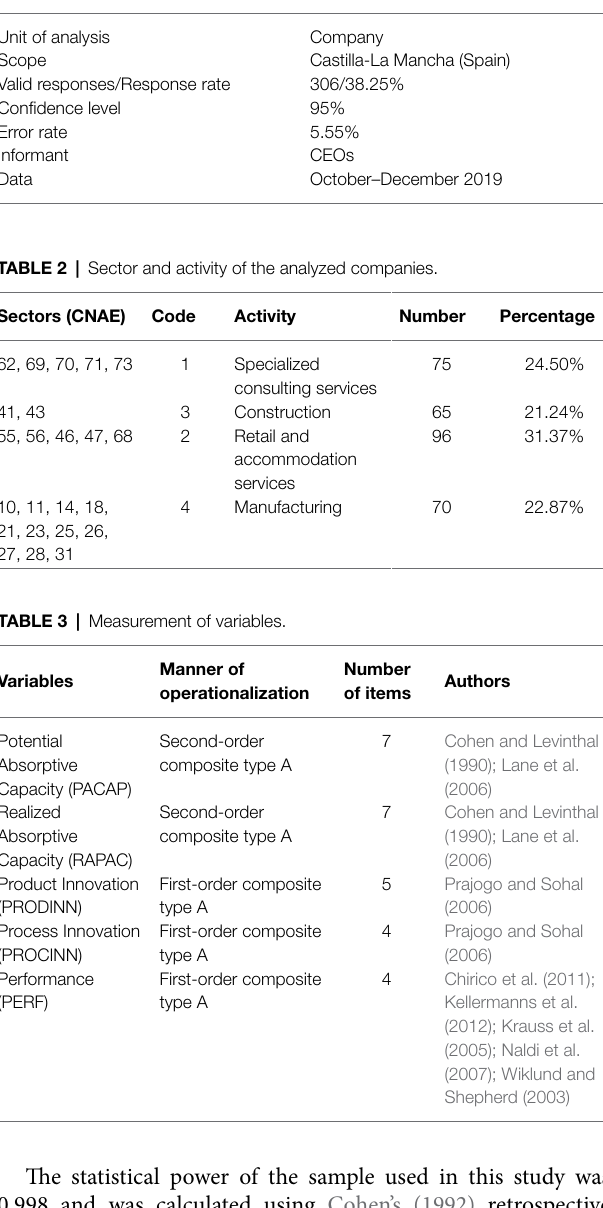
15,853 companies 800 randomly selected